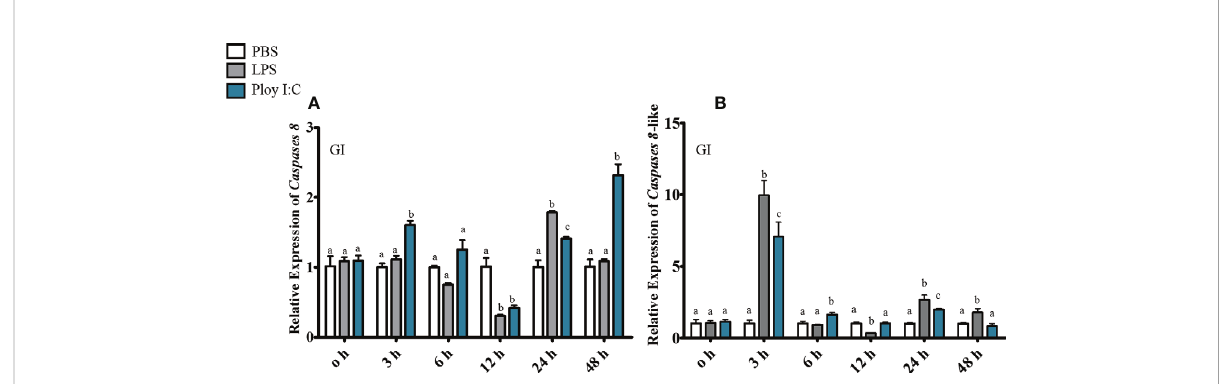
FIGURE 5 Real-time quantitative PCR was performed to detect cas8 [ (A) , Tocas8 ; (B) , Tocas8 -like] mRNA expression levels in gill after LPS and Poly(I:C) stimulation. b -actin was selected as an internal reference gene to calibrate cDNA template.These values are presented as mean ± standard deviation (n =